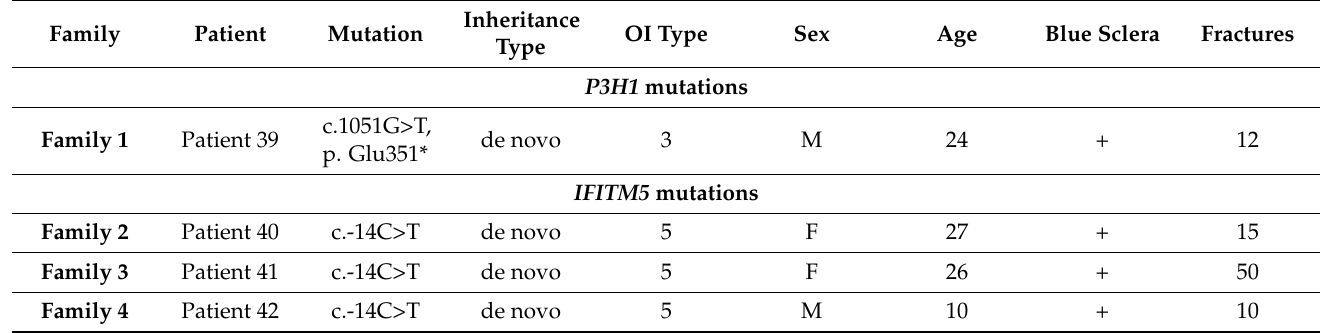
Table 2. Clinical characteristics of patients with mutations in the P3H1 and IFITM5